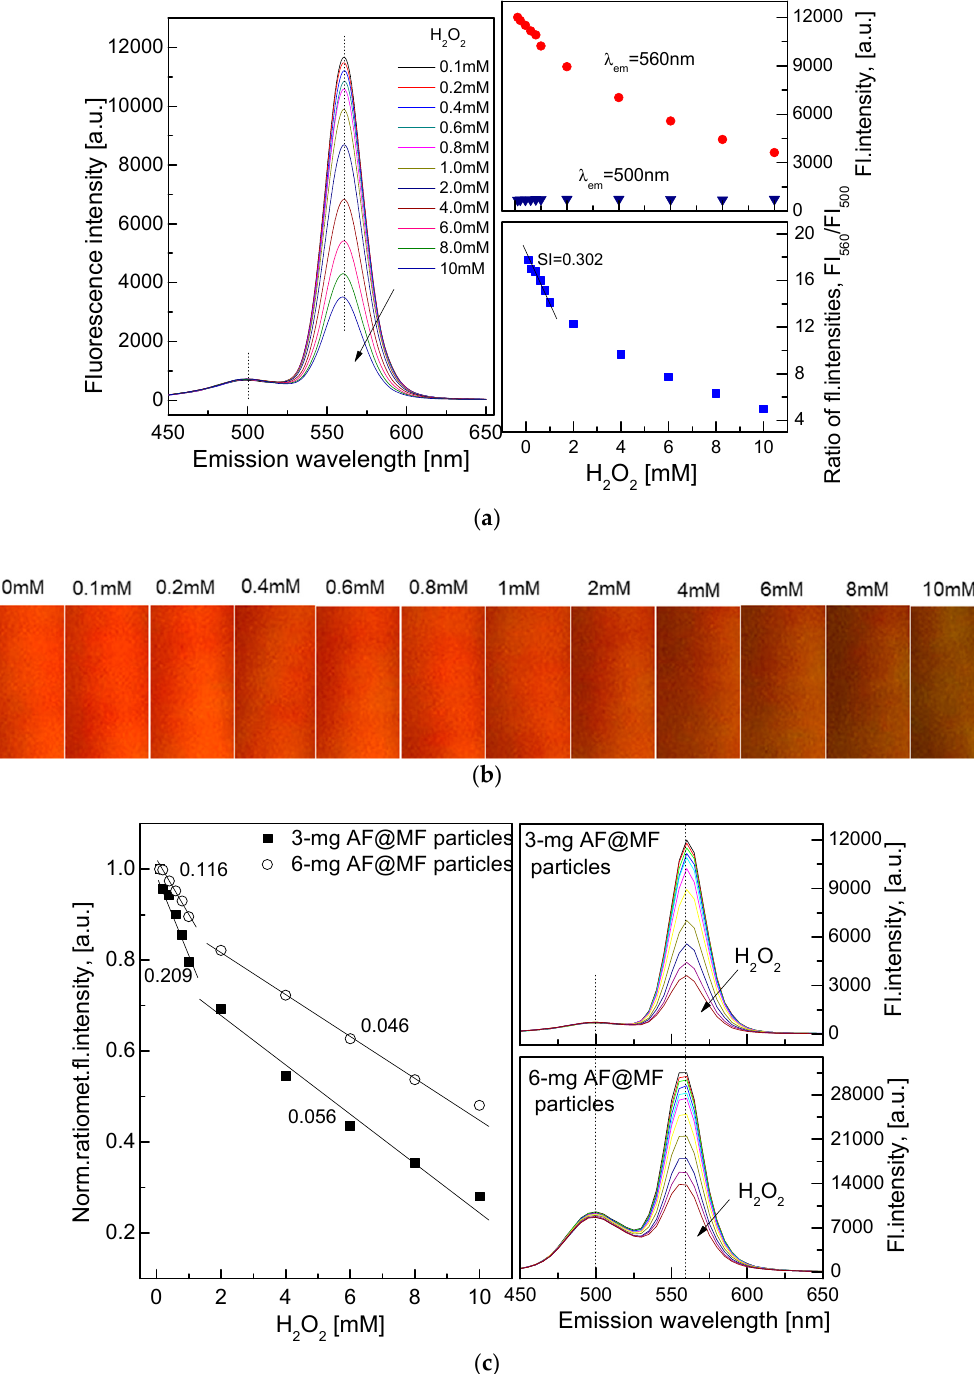
Figure 2. ( a ) Emission spectra of QD–AF membrane at different concentrations of H 2 O 2 and its calibration curve for H 2 O 2 determined by normalization of the fluorescence intensities (FI 560 /FI 500 ). ( b ) Images of fluorescence quenching of the QD–AF membrane after exposure to increasing H 2 O 2 concentrations. ( c ) Calibration curves and response of the QD–AF membranes in H 2 O 2 at concentration ranges of 0.1–1 mM and 1–10 mM using a small (3 mg) or large (6 mg) amount of reference dye particles (AF@MF particles). According to studies of Brus et al. [39], QDs can highly recover fluorescence photophysics, in which the photo-generated electron–hole pair recombines by transferring its energy to the strongly